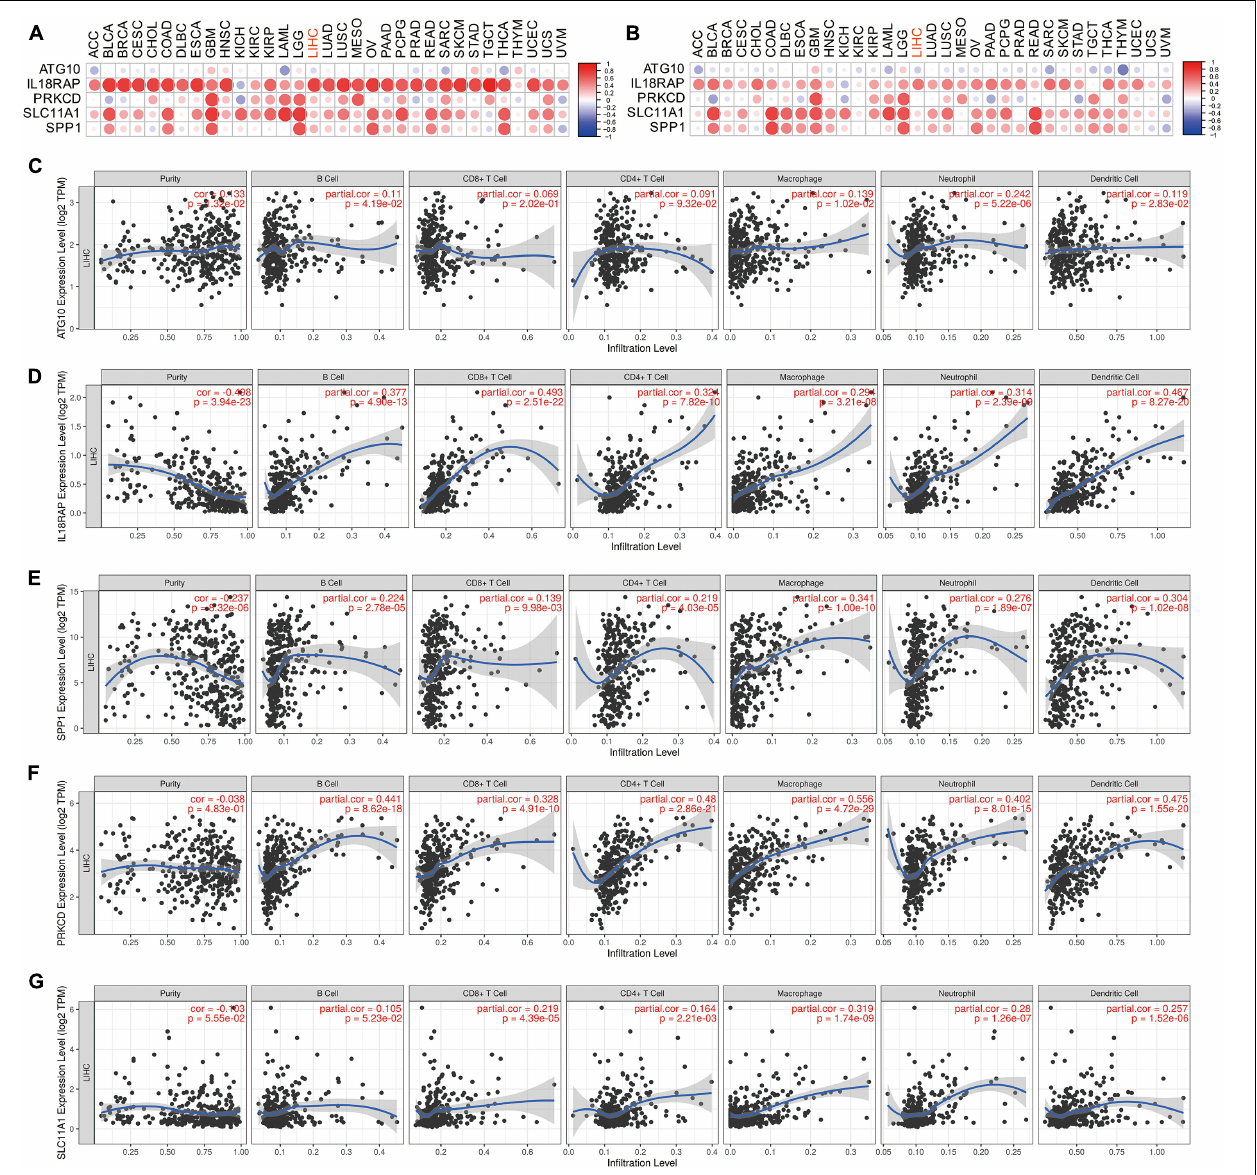
FIGURE 13 | The correlation between five genes and tumor microenvironment. (A) The correlation between genes and immune core. (B) The correlation between genes and StromalScore. (C–G) The correlation between ATG10, IL18RAP, SPP1, PRKCD, SLC11A1, and immune